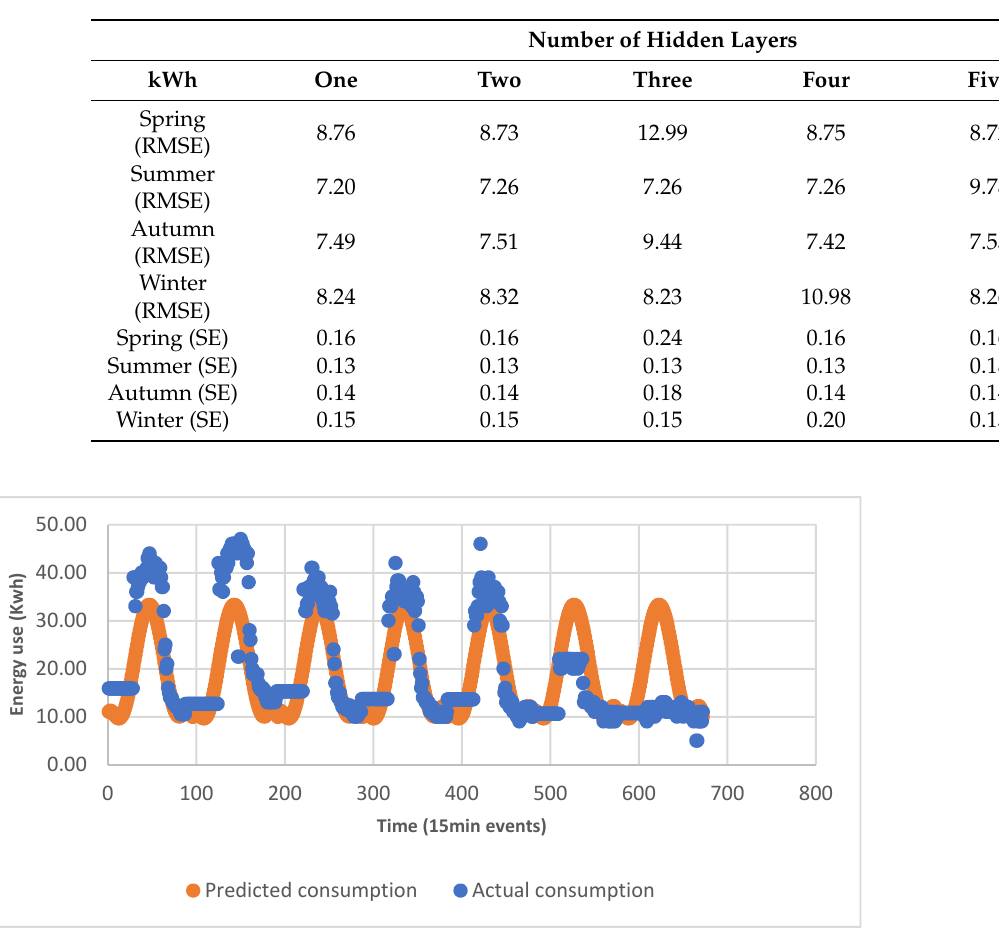
Table A2. The impact of altering the number of hidden layers on the ANN monthly predictions’ RMSE and SE.